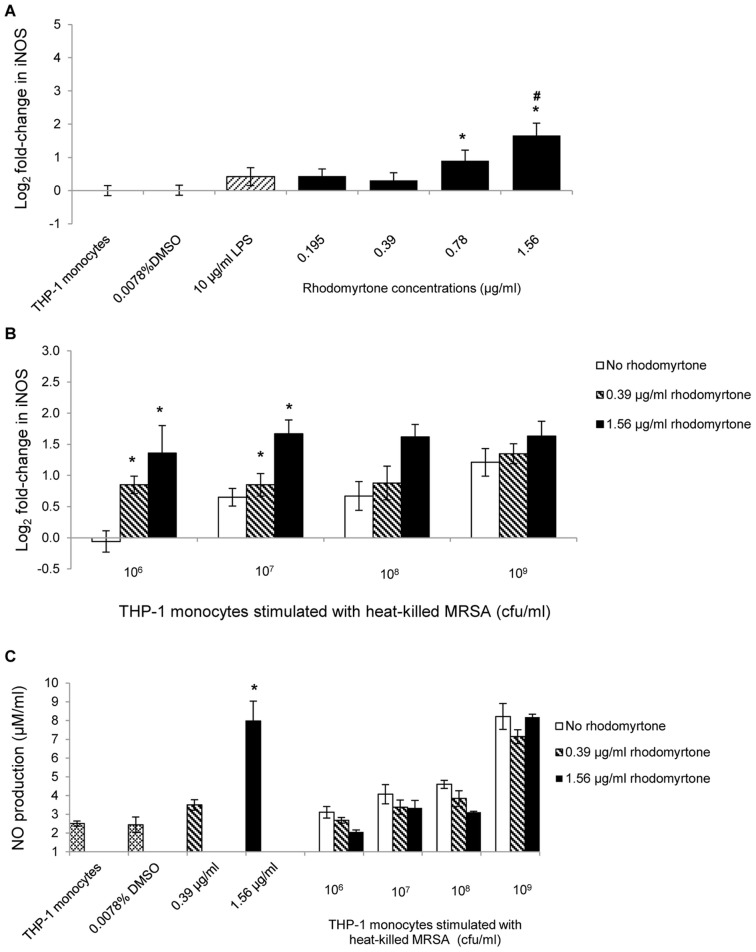
Effect of rhodomyrtone on iNOS expression in THP-1 monocytes.THP-1 cells were treated with rhodomyrtone at concentrations from 0.195 to 1.56 µg/ml for 24 h. Cells were collected and RNA was extracted for the determination of iNOS mRNA levels using real-time PCR (A). Gene expression was calculated relative to β-actin mRNA and the untreated monocytes and expressed as log2 fold change (ΔΔCt). Data are the mean ± SEM from three independent experiments and two technical replications. * p<0.05, compared with the untreated controls. # p<0.05, compared with the monocytes treated with LPS. THP-1 monocytes were stimulated with heat-killed MRSA at 106, 107, 108, and 109 cfu/ml, followed by rhodomyrtone (0.39 or 1.56 µg/ml) for 24 h. Cells were collected and RNA was extracted for the determination of iNOS mRNA levels by real-time PCR (B). * p<0.05, compared to no rhodomyrtone controls. The supernatant was collected and used to measure NO production using the Griess assay (C). Data are present the mean ± SEM from three independent experiments and two technical replicates. * p<0.05, compared with untreated monocytes.